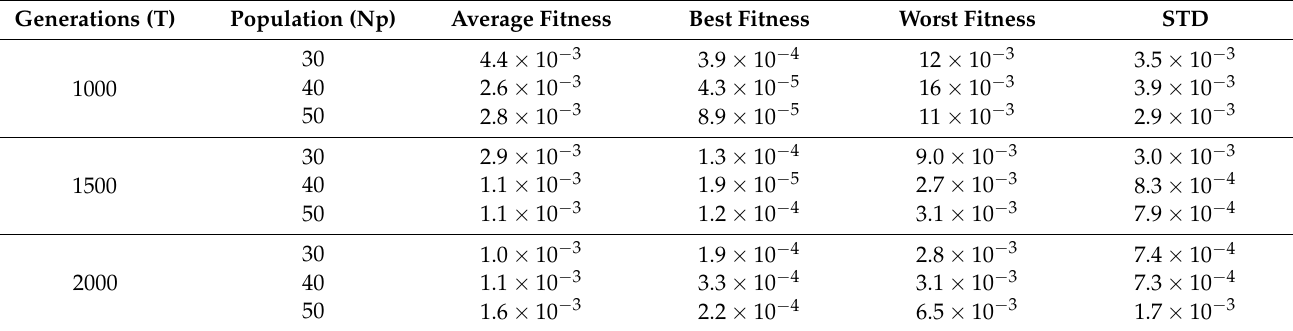
Table 3. AO parameter analysis for case 2.